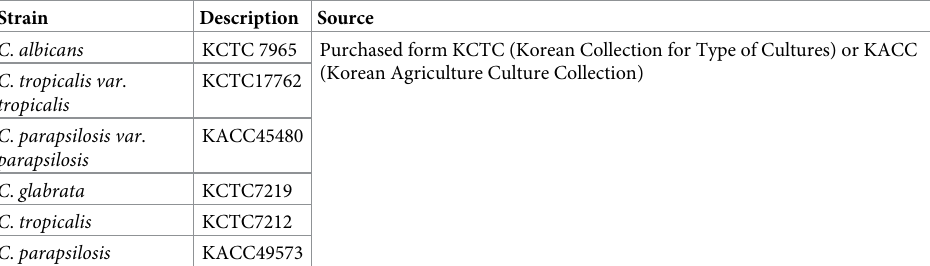
Table 1. Strains used in this